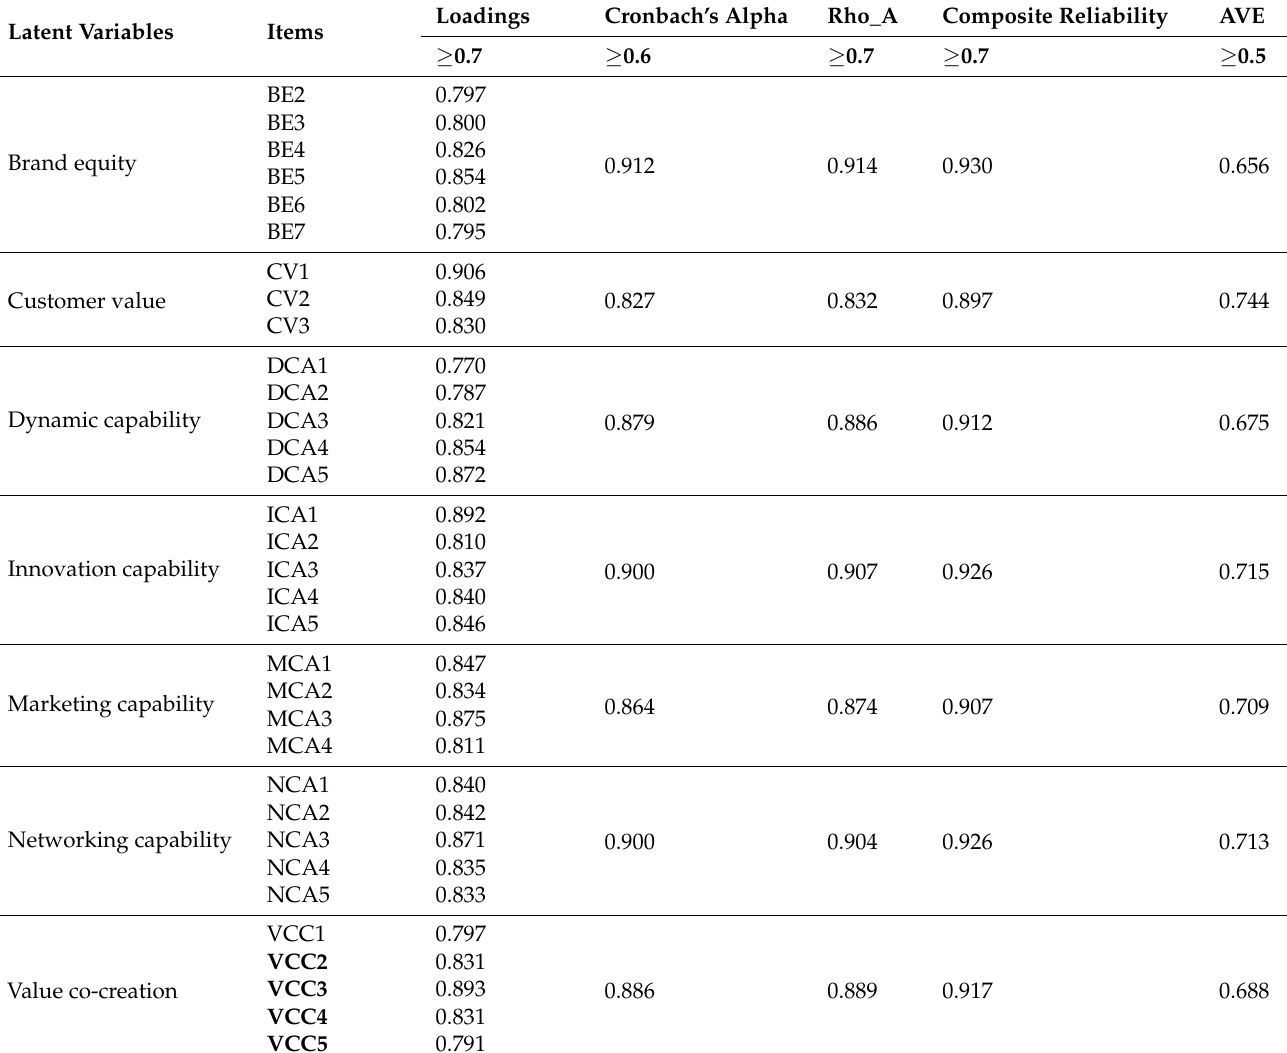
Table 2. Summary of key